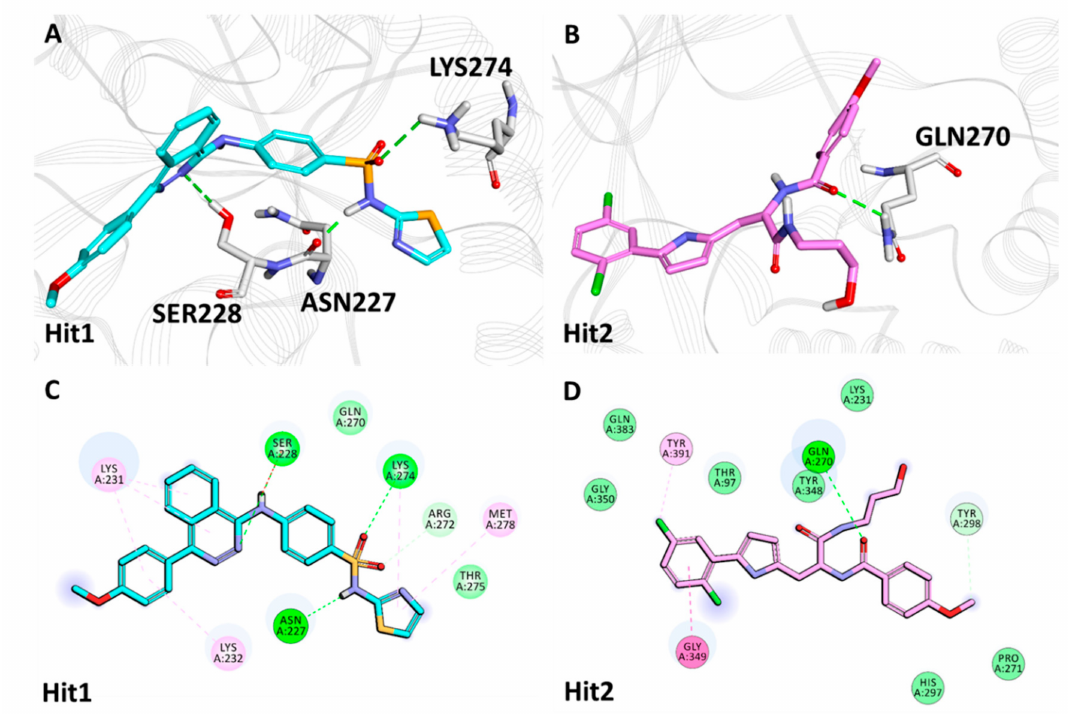
Figure 6. The 3D and 2D intermolecular interactions of synthetic compound hits (Hit1: A , C ; Hit2: B , D ) with the active site residues of